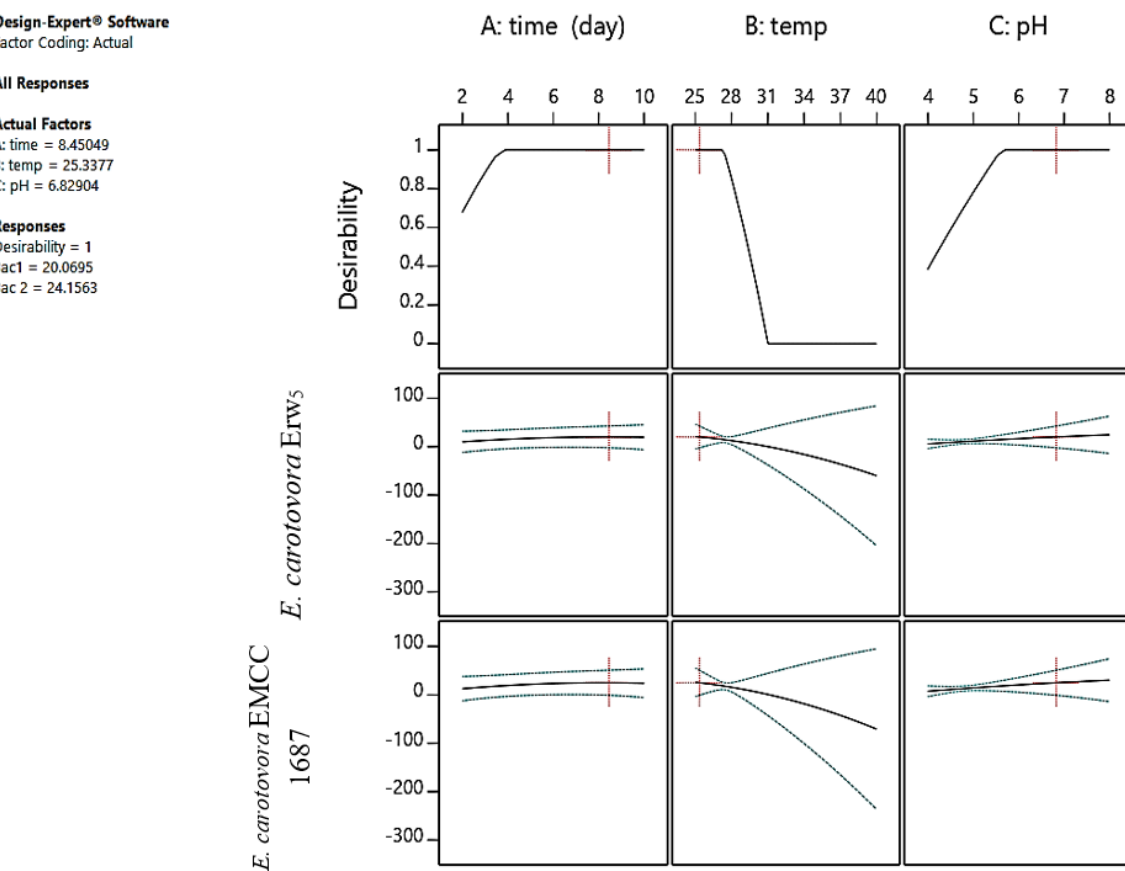
Figure 4. Best operating parameters for antimicrobial production by S. californics (22/30a) and antibacterial activity against E. carotovora Erw 5 and E. carotovora EMCC 1687, as predicted by RSM analysis with central composite design (CCD).